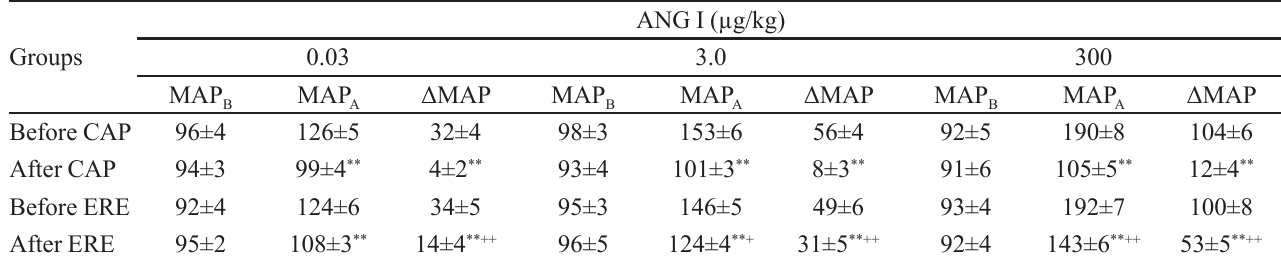
MAP : MAP before ANG I injection; MAP B are presented as the mean ± S.E.M. ** p<0.01 compared with MAP values before CAP or ERE administration. ++ p<0.01 compared with MAP after CAP